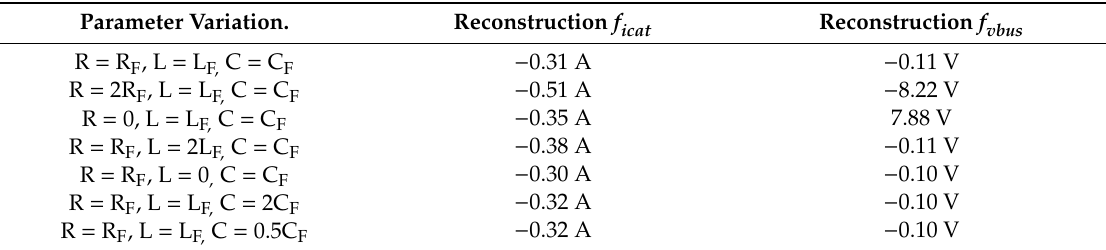
Table 2. Analysis of fault reconstructions in steady state for a sensor fault-free scenario and parameter variation.